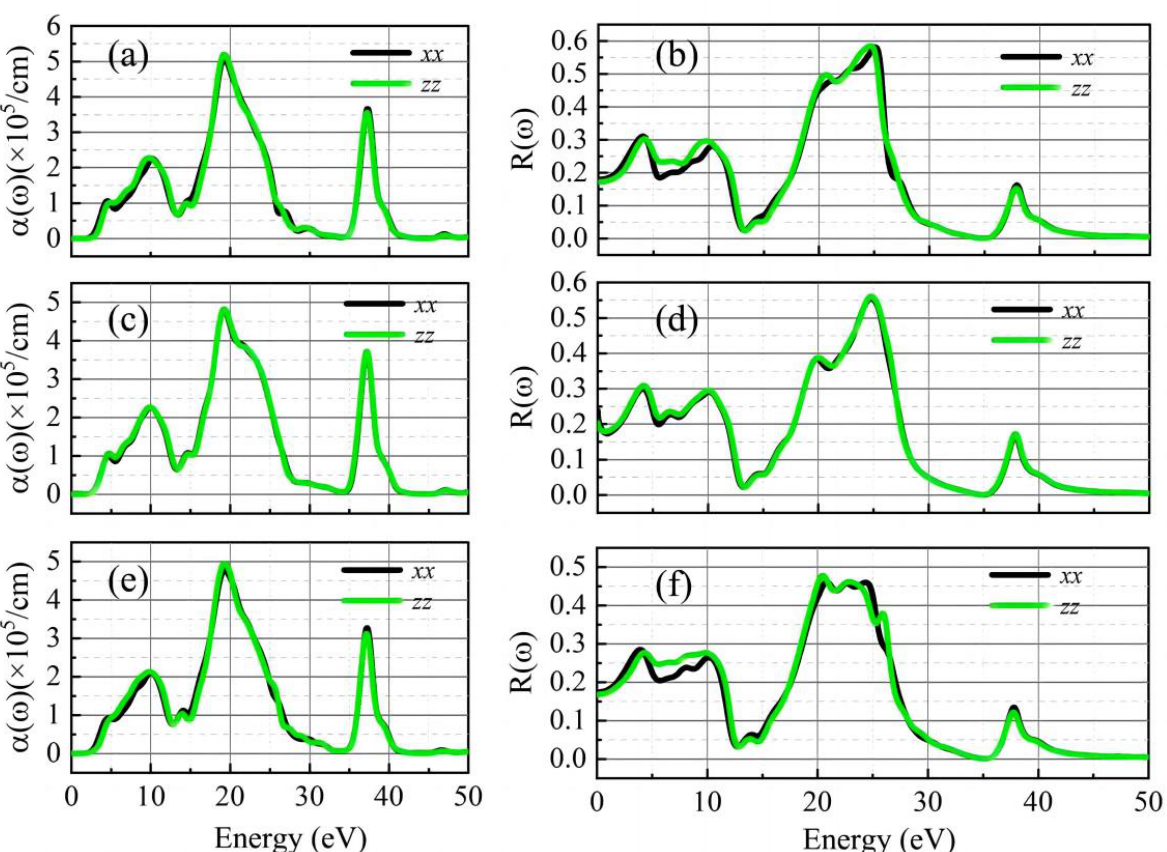
Figure 6. The absorption spectra ( a , c , e ) and reflectivity spectra ( b , d , f ) of the materials. The ( top ) represents pure BaTiO 3 , the ( middle ) is Ba 0.875 TiCe 0.125 O 3 , and the ( bottom ) is BaTi 0.875 Ce 0.125 O 3 .